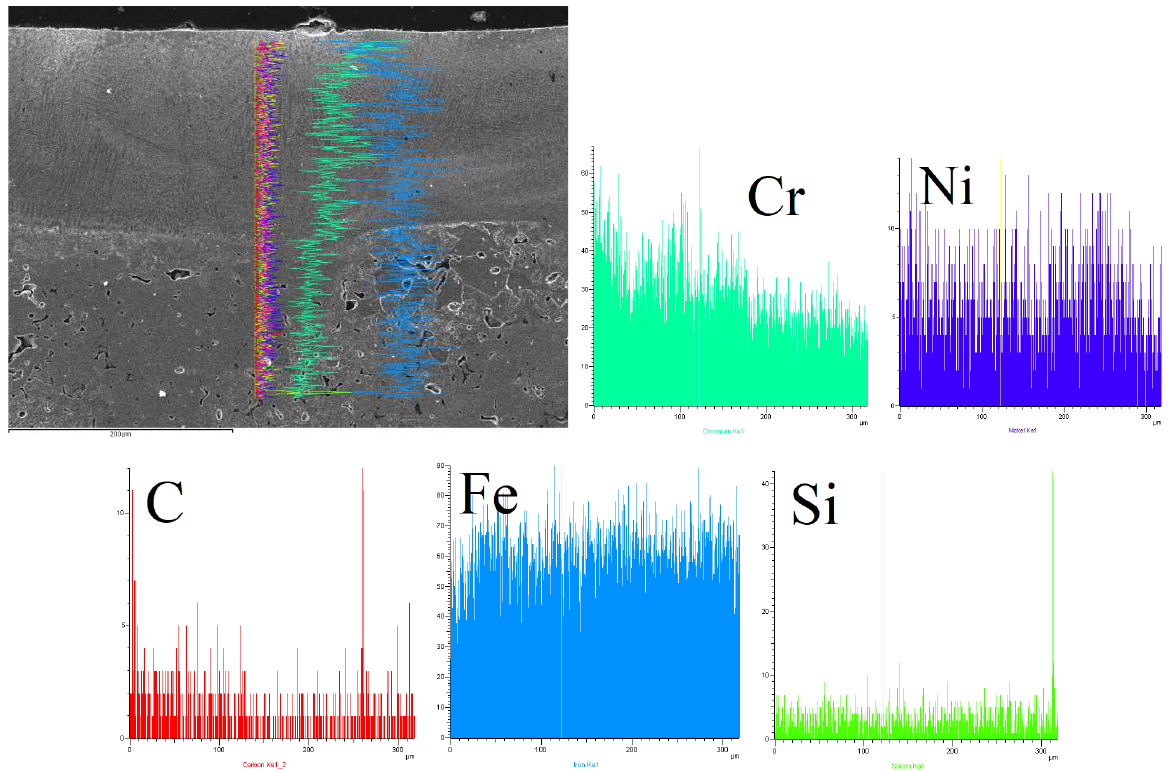
Figure 12. Line mapping analysis EDS on cross-section after laser alloying process for sample 2.